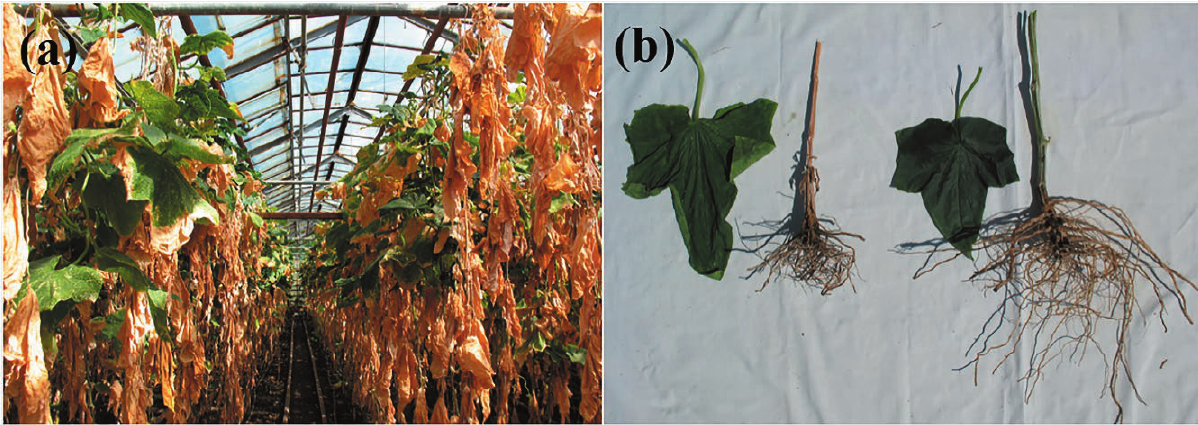
Figure 1. (a) Cucumber plants (variety Koroliok) affected by Plectosphaerlla melonis (isolate 502) in a greenhouse. (b) Leaf and root of an affected plant (left) and a healthy plant (right).